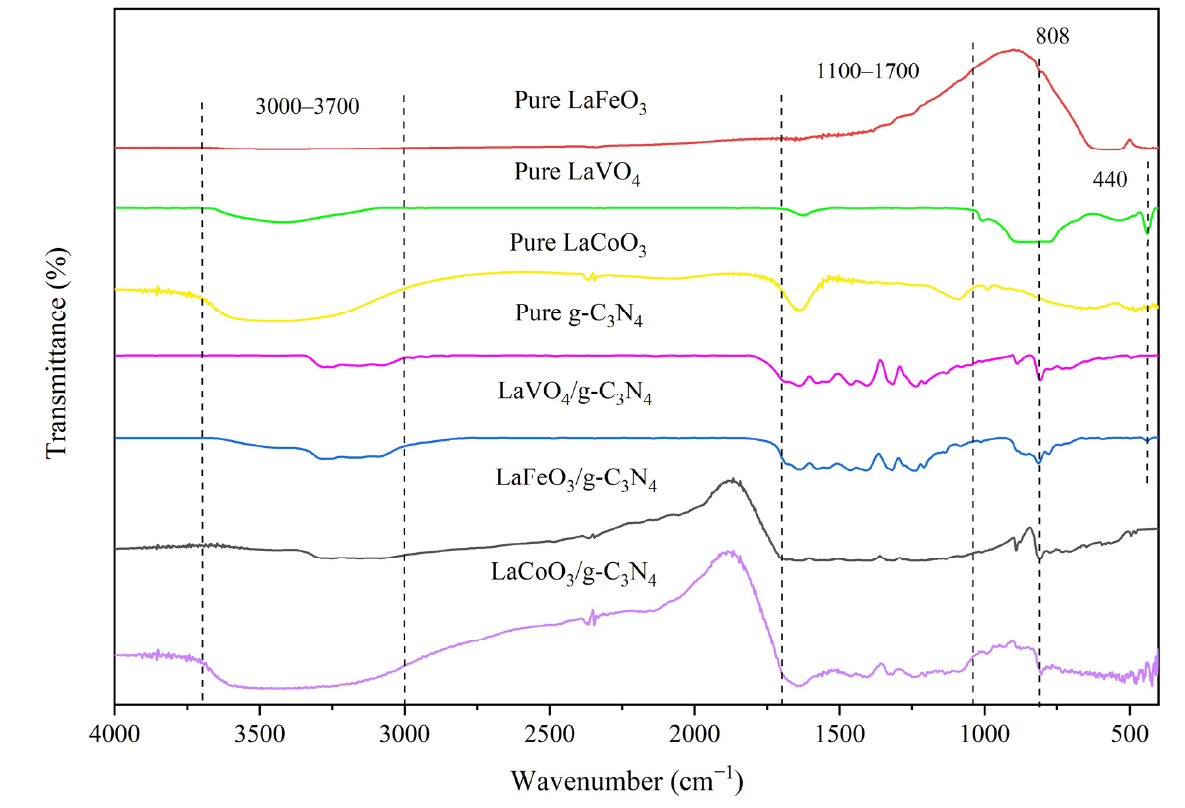
Figure 3. FT-IR absorbance spectra of obtained